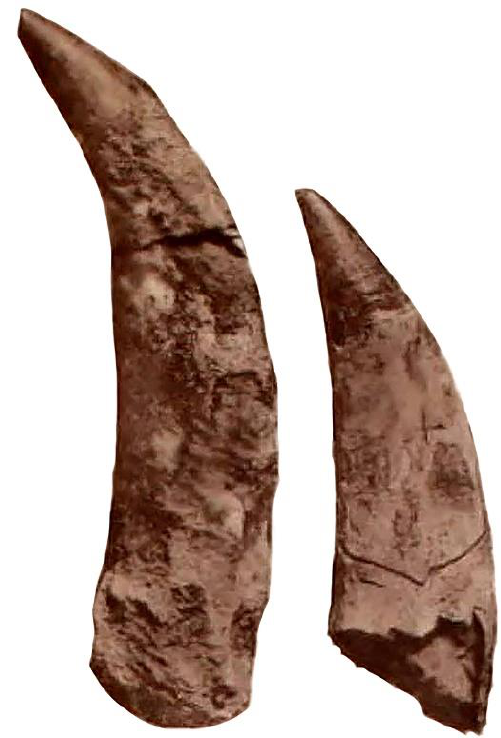
Figure 2. Excerpt from Portis (1885) [8] plate IX (Figure 106a,b) representing two of the teeth assigned to Tursiops miocaenus by Portis.